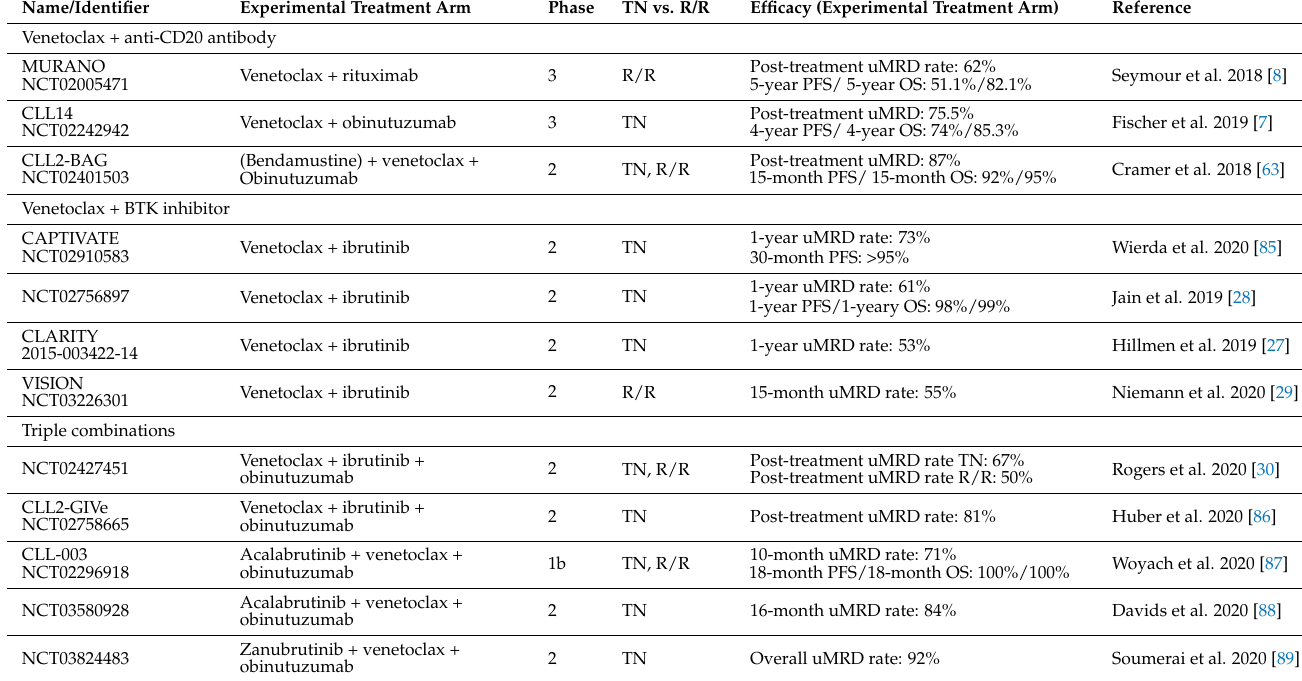
Table 1. Selected results of studies on time-limited combination strategies.